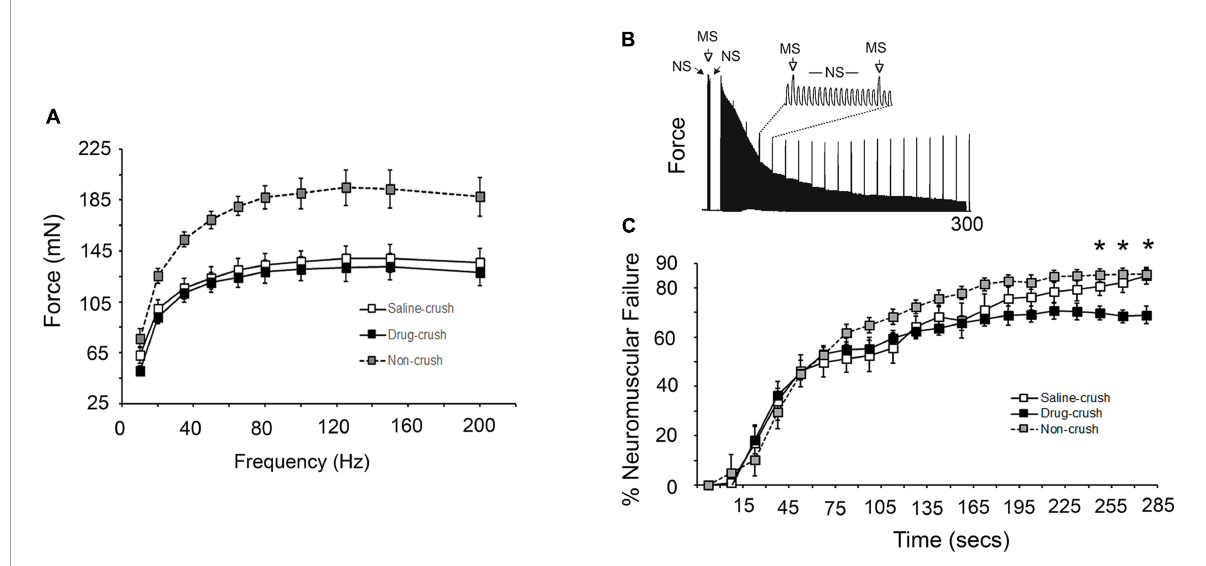
FIGURE5 Electrophysiological assessment of soleus force production and neural failure. (A) Force generated by direct simulation of soleus muscles at different frequencies at 21 days post-crush. There is no significant difference between the saline-crush (open squares) and AP5&CNQX-treated (drug-crush) muscles (black squares). Gray squares show data from control muscles with no nerve crush. Control non-crush muscles were significantly stronger at all stimulation frequencies compared to saline-crush or drug-crush muscles ( n = 4 muscle for saline and drug-crush and 6 for non-crush, two-way ANOVA with Tukey post-hoc test, p < 0.001). (B) Representative tracing of force measurements where direct muscle stimulation (MS) was intermittently superimposed every 15 s on trains of tibial nerve stimulation (NS). Difference in force production between MS and NS stimulation represents the contribution of neuromuscular transmission failure to muscle fatigue. (C) Increases in percent neuromuscular failure over 285 s of stimulation MS vs. NS stimulation. Neuromuscular failure was significantly lower in drug-crush soleus compared to saline-crush soleus by 255 s (asterisks, two-way ANOVA with Tukey post-hoc test, p < 0.001). NF was determined every 15 s using the equation NF = (F–MF)/(1–MF) where NF is neurotransmission failure, F is percent force loss during nerve stimulation, and MF is percent force loss due to contractile fatigue.